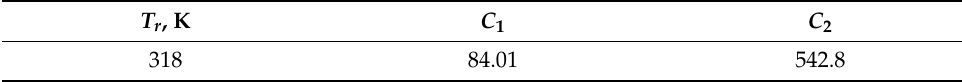
Table 9. Values of constants of the Williams–Landel–Ferry shift function.